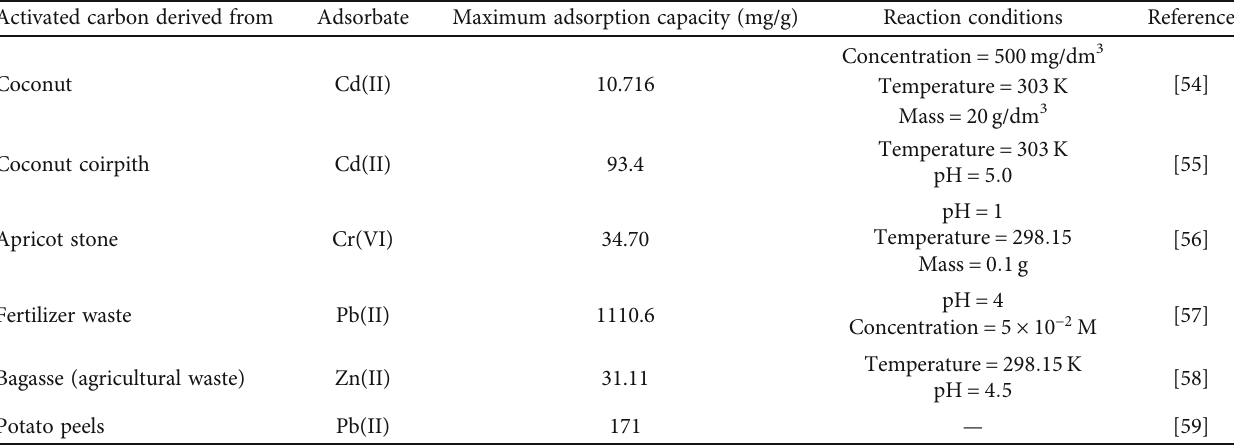
Table 3: Adsorption of heavy metal ions onto activated carbon derived from various sources with their maximum adsorption capacity and reaction